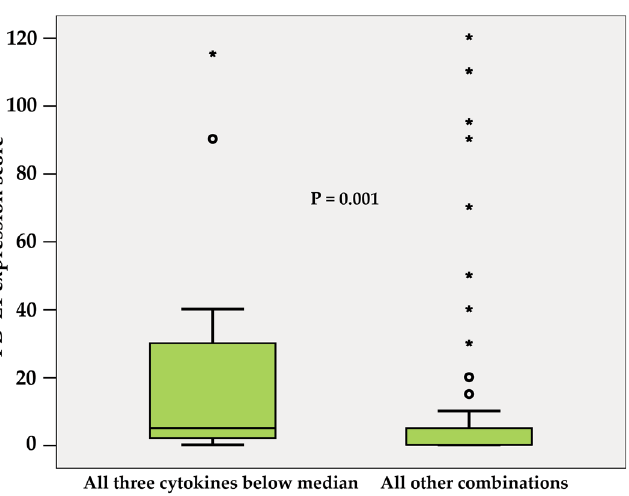
Figure 5. PD-L1 expression in tumours of BC patients stratified by combined VEGF, TNF-β and IL-15 levels (all three below the median vs. all other combinations). The length of the boxes is the interquartile range (IQR) that represents values between the 75th and 25th percentiles. Values more than three IQRs from the end of a box are labelled as extreme (*). Values more than 1.5 IQRs but less than 3 IQRs from the end of the box are labelled as outliers (O). The median is depicted by a horizontal line.